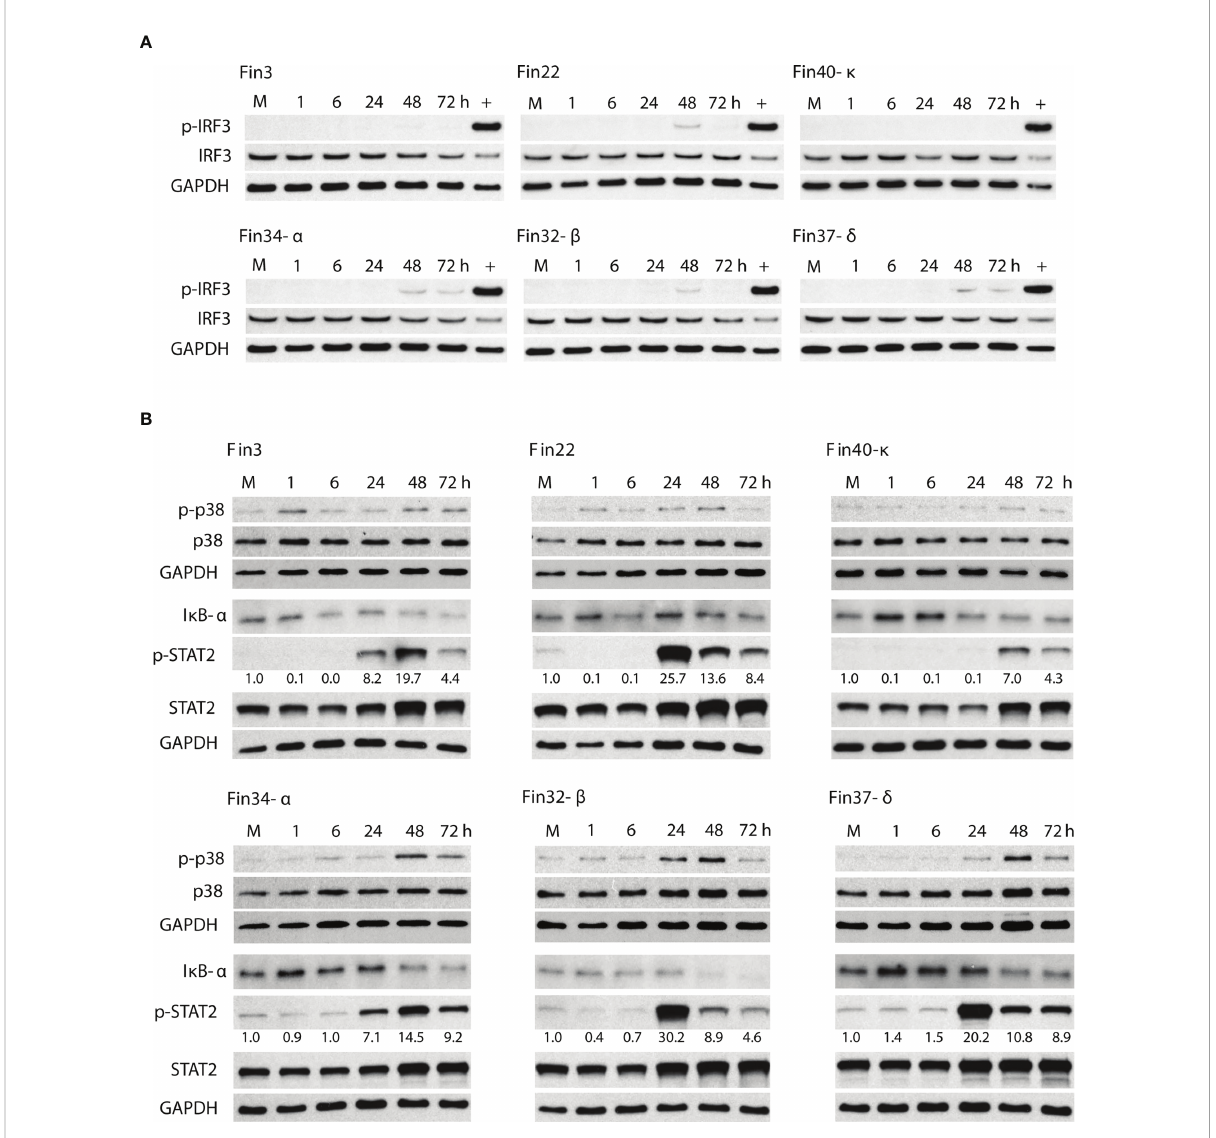
FIGURE 3 Activation of signaling molecules involved in the induction of interferon, cytokine and ISG gene expression. Total cellular protein samples were collected at various time points following infection of Calu-3 cells with different SARS-CoV-2 variants at a MOI of 1 TCID 50 /cell. Representative immunoblots out of 3 repeated experiments are shown. (A) Immunoblots were probed with antibodies against phosphorylated interferon regulatory transcription factor 3 (p-IRF3) and total IRF3. Cellular protein samples collected at 8 h after Sendai virus infection in Calu-3 cells was used as a positive control (+). GAPDH was used as a loading control for p-IRF3. The immunoblot was carried out twice. (B) Immunoblots stained with antibodies against phosphorylated p38 (p-p38) and p38 (carried out once), nuclear factor of kappa light polypeptide gene enhancer in B- cells inhibitor alpha (I k B- a ) and phosphorylated signal transducer (carried out twice) and activator of transcription 2 (p-STAT2) and STAT2 (carried out twice). p-STAT2 levels were quanti fi ed by ImageJ and the fold over mock values are seen below the p-STAT2 immunoblot. GAPDH was used as a loading